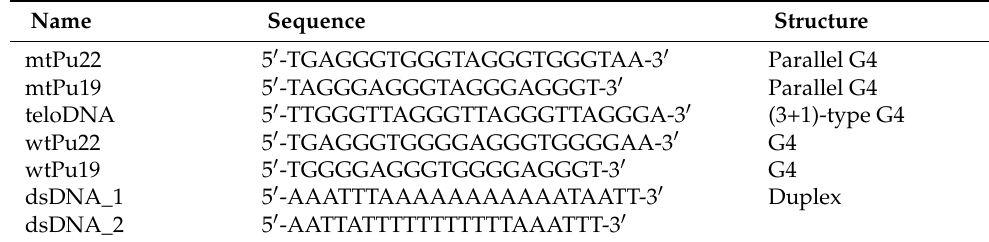
Table 1. Sequences of DNAs used in this